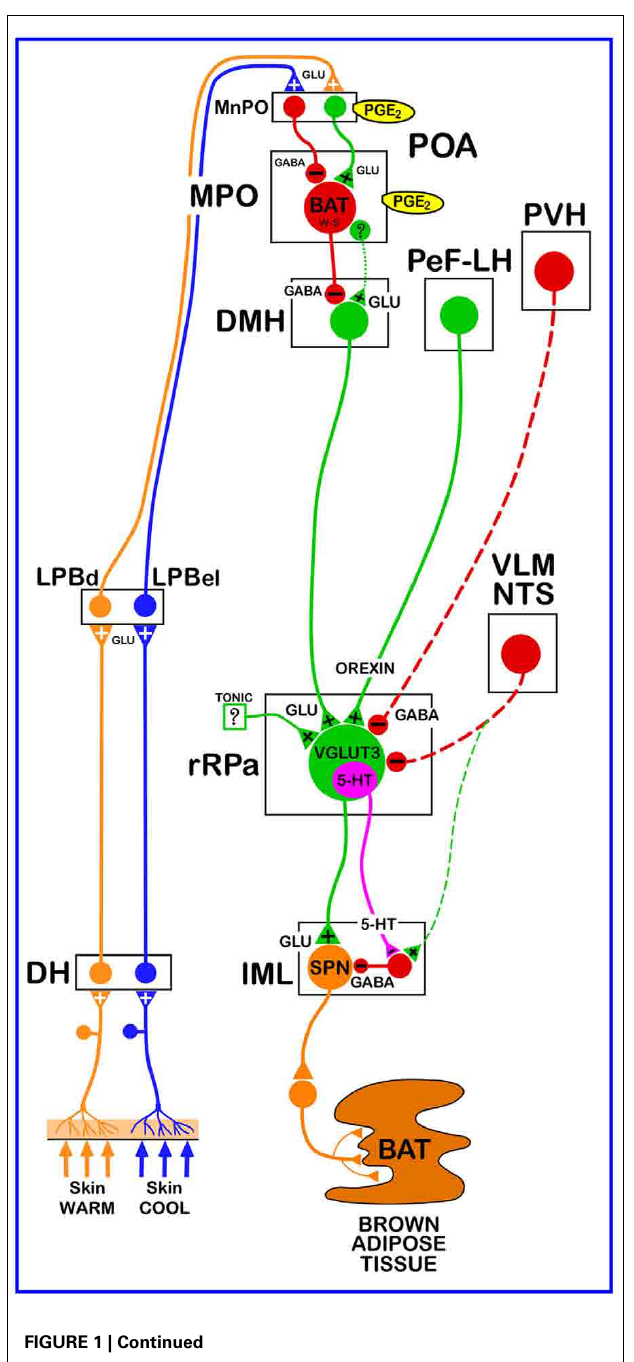
FIGURE 1 | Schematic of the proposed neuroanatomical and neurotransmitter model for the core thermoregulatory network and other CNS sites controlling brown adipose tissue (BAT) thermogenesis. Cool and warm cutaneous thermal sensory receptors transmit signals to respective primary sensory neurons in the dorsal root ganglia which relay this thermal information to second-order thermal sensory neurons in the dorsal horn (DH). Cool sensory DH neurons glutamatergically activate third-order sensory neurons in the external lateral subnucleus of the lateral parabrachial nucleus (LPBel), while warm sensory DH neurons project to third-order sensory neurons in the dorsal subnucleus of the lateral parabrachial nucleus (LPBd).Thermosensory signals for thermoregulatory responses are transmitted from the LPB to the preoptic area (POA) where GABAergic interneurons in the median preoptic (MnPO) subnucleus are activated by glutamatergic inputs from cool-activated neurons in LPBel and inhibit a BAT-regulating population of warm-sensitive (W-S) neurons in the medial preoptic (MPO) subnucleus. In contrast, glutamatergic interneurons in the MnPO, postulated to be excited by glutamatergic inputs from warm-activated neurons in LPBd, exciteW-S neurons in MPO. Prostaglandin (PG) E 2 binds to EP3 receptors to inhibit the activity ofW-S neurons in the POA. PreopticW-S neurons providing thermoregulatory control of BAT thermogenesis inhibit BAT sympathoexcitatory neurons in the dorsomedial hypothalamus (DMH) which, when disinhibited during skin cooling, excite BAT sympathetic premotor neurons in the rostral ventromedial medulla, including the rostral raphe pallidus (rRPa), that project to BAT sympathetic preganglionic neurons (SPN) in the spinal intermediolateral nucleus (IML). Some BAT premotor neurons can release glutamate (GLU) to excite BAT SPNs and increase BAT sympathetic nerve activity, while others can release serotonin (5-HT) to interact with 5-HT 1A receptors, potentially on inhibitory interneurons in the IML, to increase the BAT sympathetic outflow and thermogenesis. Orexinergic neurons in the perifornical lateral hypothalamus (PeF-LH) project to the rRPa to increase the excitability of BAT sympathetic premotor neurons. Neurons in the paraventricular hypothalamic (PVH) nucleus exert an inhibitory influence on BAT thermogenesis, possibly via a GABAergic input to BAT sympathetic premotor neurons in rRPa. Activation of neurons in the ventrolateral medulla (VLM) or in the nucleus of the solitary tract (NTS) produces an inhibition of BAT thermogenesis, potentially via a non-GABAergic input to rRPa or by activation of spinal inhibitory interneurons in the IML.VGLUT3, vesicular glutamate transporter